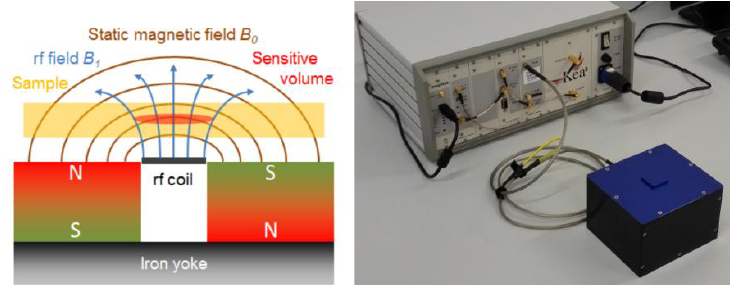
Figure 6. Schematic diagram of unilateral nuclear magnetic resonance system measurement.